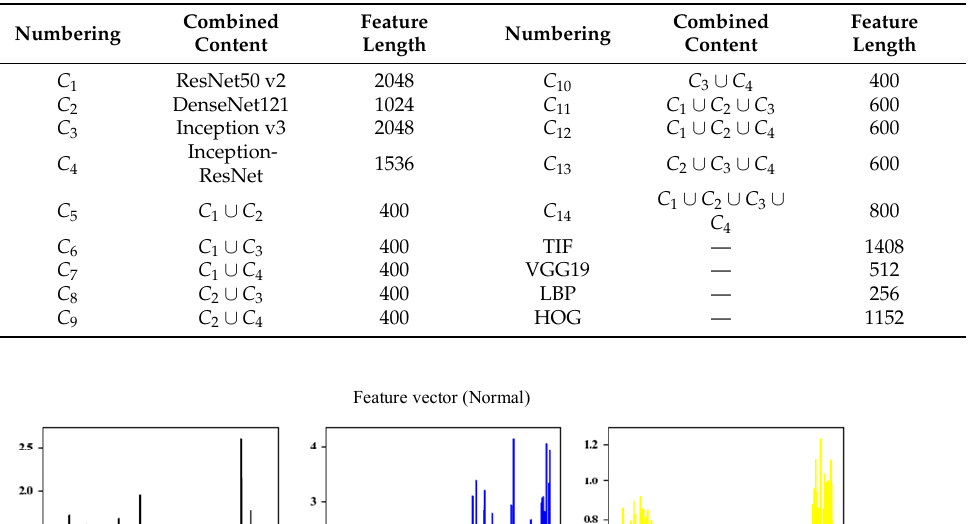
Table 2. Model combinations and feature dimensions. ( ∪ represents features for serial fusion).